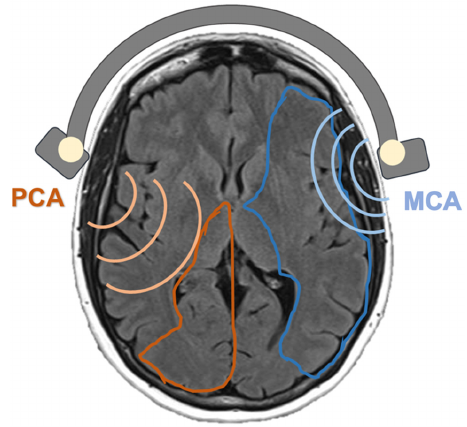
Figure 1. Diagram of the MCA/PCA insonation .